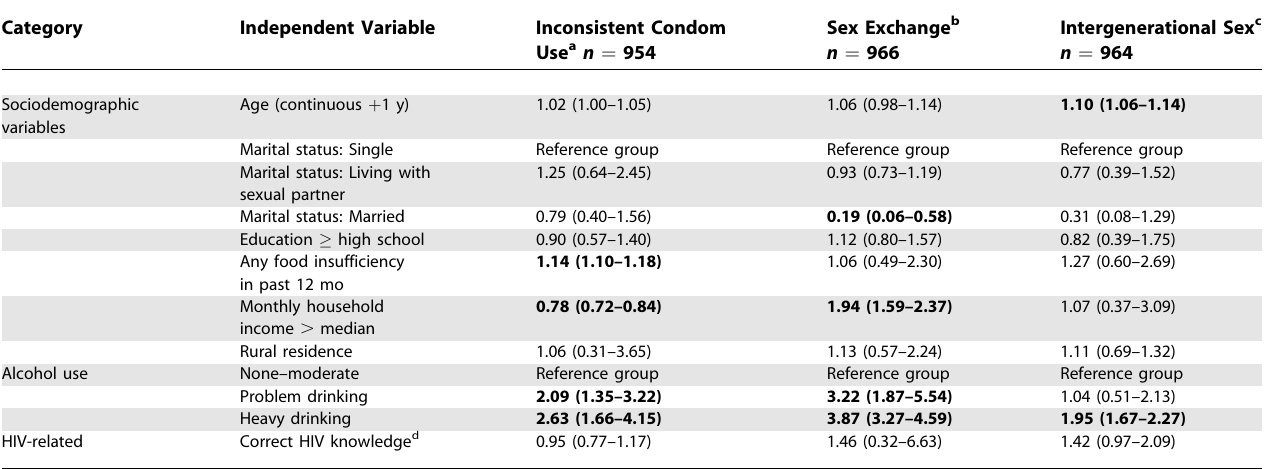
Table 4. Adjusted Associations with Unprotected Sex, Sex Exchange, and Intergenerational Sex for Men, Botswana and Swaziland